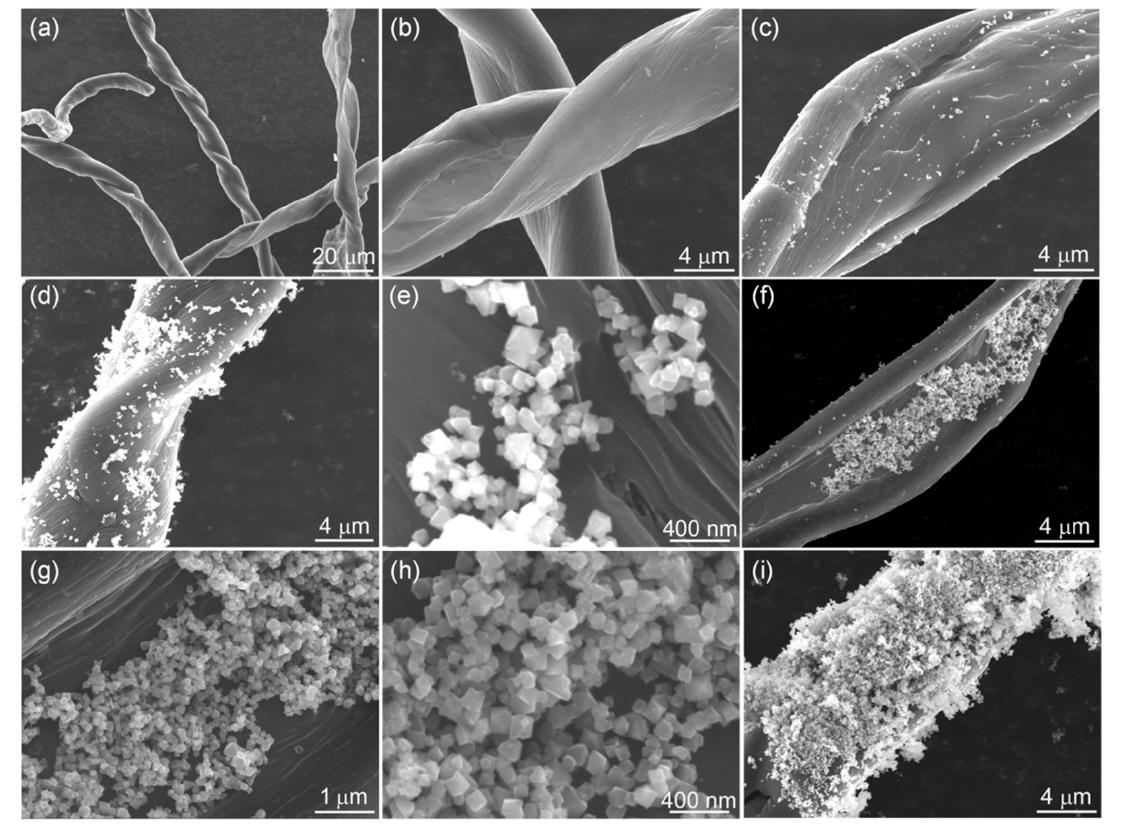
Figure 2. SEM images of the synthesized samples: ( a , b ) CCF, ( c ) NiFe 2 O 4 /CCF-1, ( d , e ) NiFe 2 O 4 /CCF-2, ( f – h ) NiFe 2 O 4 /CCF-3, and ( i ) NiFe 2 O 4 /CCF-4.